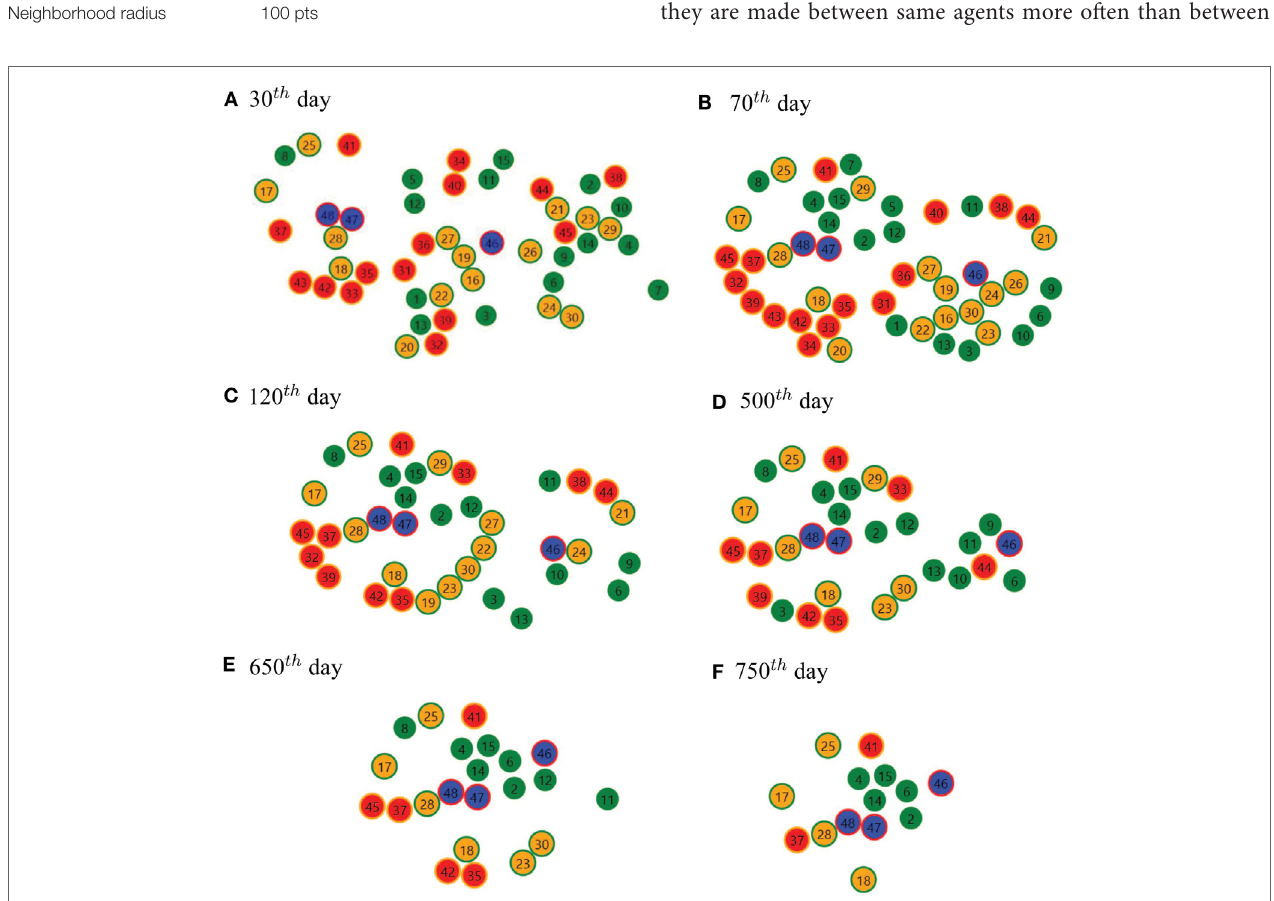
FigUre 14 | example of an agent population decaying in time: (a) On the 30th day, (B) on the 70th day, (c) on the 120th day, (D) on the 500th day, (e) on the 650th day, and (F) on the 750th day